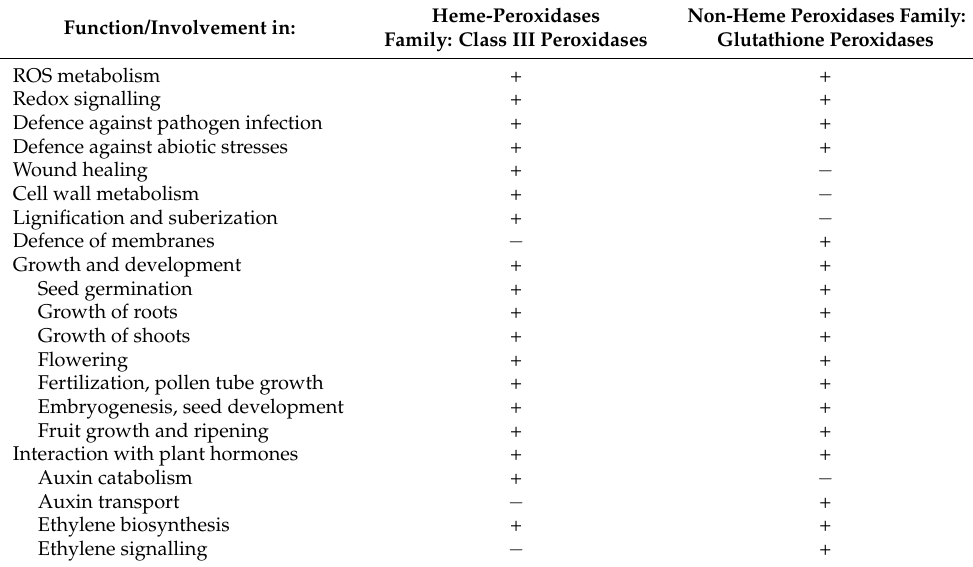
Table 3. Comparison of the involvement of heme-containing Class III peroxidases and the non-heme GPX(L) enzyme family in stress responses, growth and developmental processes and interactions with auxin and ethylene